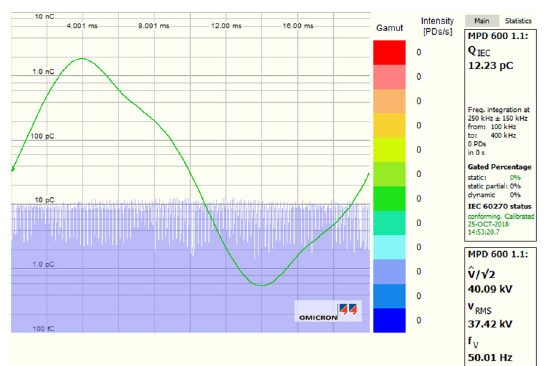
Figure 1. The test voltage waveform and PD characteristic in the HV and PD tests.